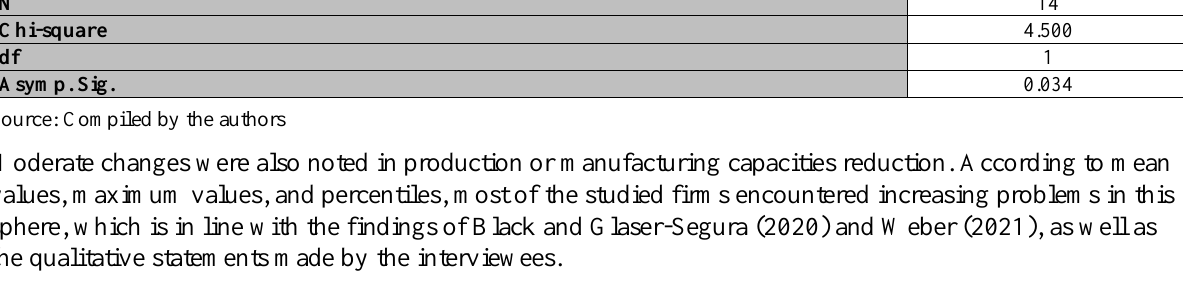
Table 10. Reductions in Production or Manufacturing Capacities (Descriptive Statistics)